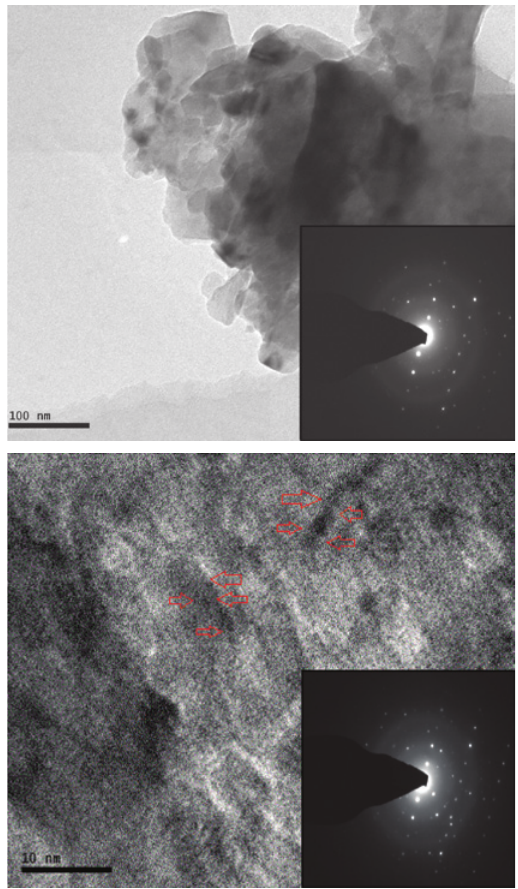
S (100 and 10 nm). 2 3